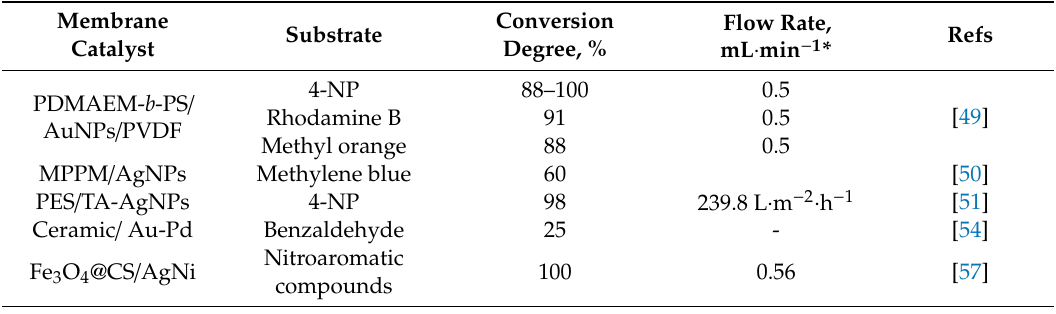
Table 5. Catalytic activity of metal nanoparticles immobilized into di ff erent membrane surface with respect to various